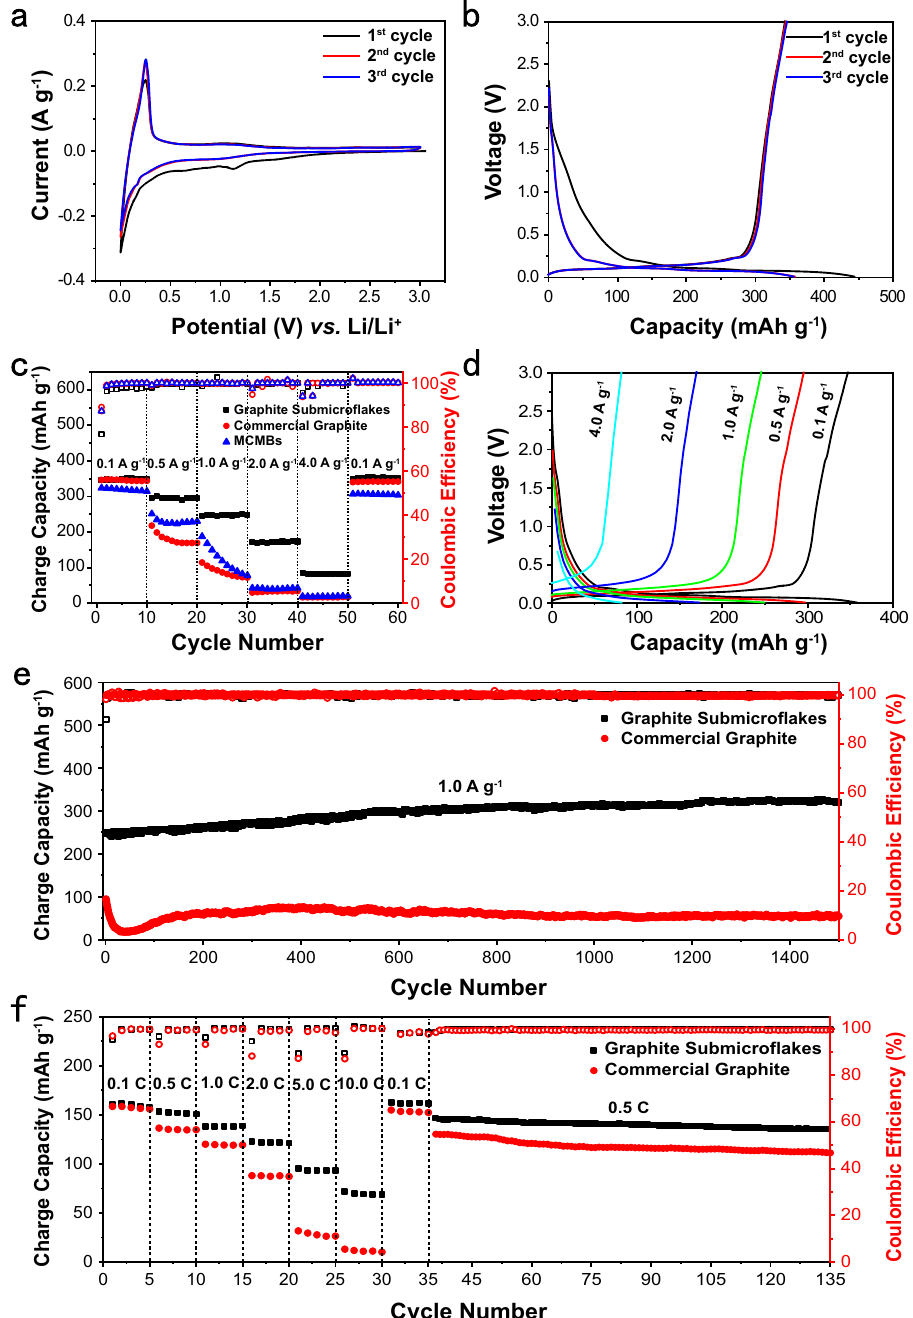
Fig. 4 Electrochemical lithium storage performance of graphite. a Cyclic voltammogram curves of graphite submicro fl akes cycled between 0.01 and 3.0 V. b Discharge/charge curves of graphite submicro fl akes at a current density of 0.1 A g − 1 . c Rate capability of graphite submicro fl akes and commercial graphite from 0.1 to 4.0 A g − 1 . d Discharge/charge curves of graphite submicro fl akes from 0.1 to 4.0 A g − 1 . e Long-term cycle performance of graphite submicro fl akes and commercial graphite at 1.0 A g − 1 . f Rate capability of full cells at 0.1C ‒ 10C (1C = 170 mA g − 1 ). deliver an initial reversible capacity of ~250 mAh g – 1 at 1.0 A g – 1 . The cycling capacity slowly increases to ~320 mAh g – 1 at the fi rst 1200 cycles and then maintains the maximum capacity even up to 1500 cycles. The reversible capacity of graphite submicro fl akes at the 1500 th cycle is 5.9 times higher than 54 mAh g – 1 of commercial